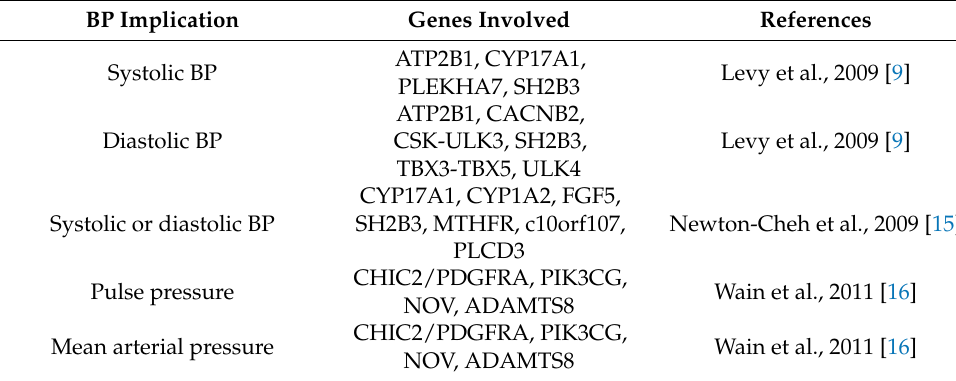
Table 2. Polygenic form of essential arterial hypertension, data from